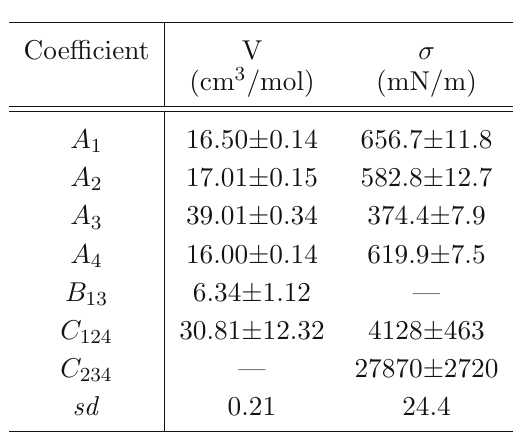
Table 4 Coefficients A fit in the system CaO-FeO-Fe 2 O 3 -MgO at the temperature of 1623 K.